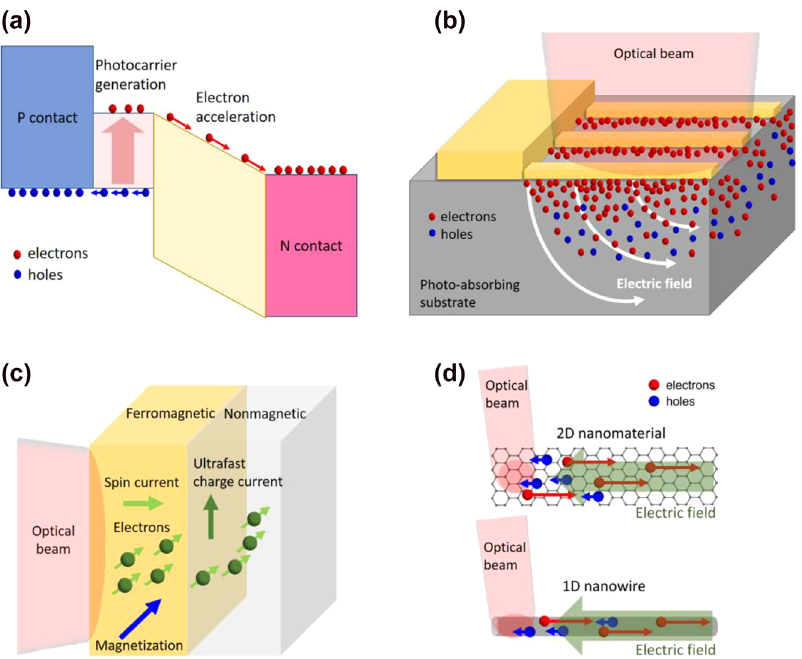
Figure 2: Schematics that illustrate the ultrafast carrier dynamics enabling terahertz generation and detection. (a) Uni-traveling carrier photodiodejunctions,whereelectron-dominantcarriertransportenableshigh-powerCWterahertzgeneration.(b)Plasmonicnanostructures, where plasmonics-enhanced near-field photocarrier generation enables pulsed and CW terahertz generation and detection. (c) Spintronic materials, where ultrafast electronic spin-to-charge conversion enables broadband terahertz generation. (d) Low-dimensional materials, where high mobility photocarrier transport enables terahertz generation and detection.